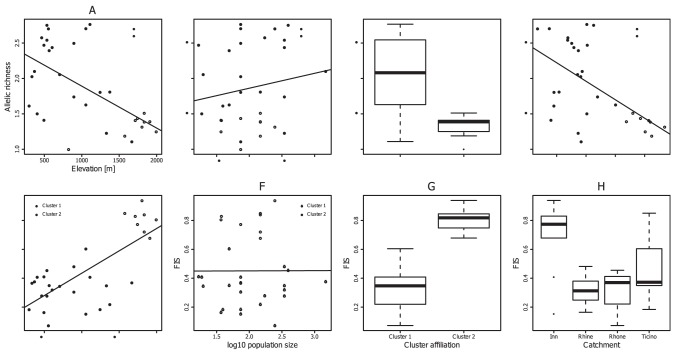
Population graphs showing the genetic relationships between Myricaria germanica sites, with catchments shown in different colors (Inn: blue; Rhine, orange; Rhone, red; Ticino, yellow); the size of circles is proportional to effective population size.